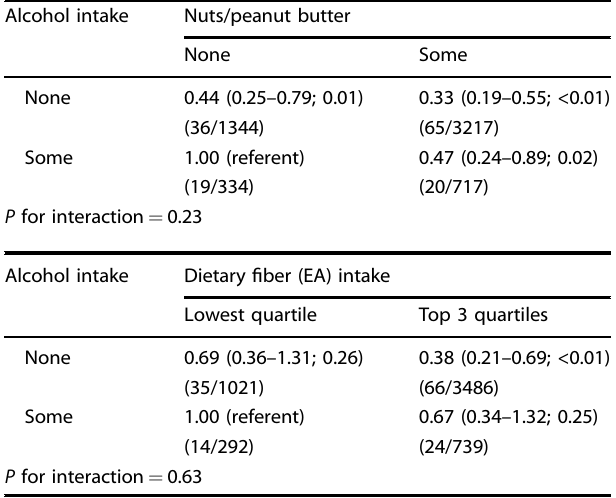
Table 3. Ages 14 – 17-year intakes of alcohol (none vs some) jointly classi fi ed with same age intakes of nuts/peanut butter (none vs some) in multivariable logistic models of risk for biopsy-con fi rmed BBD a